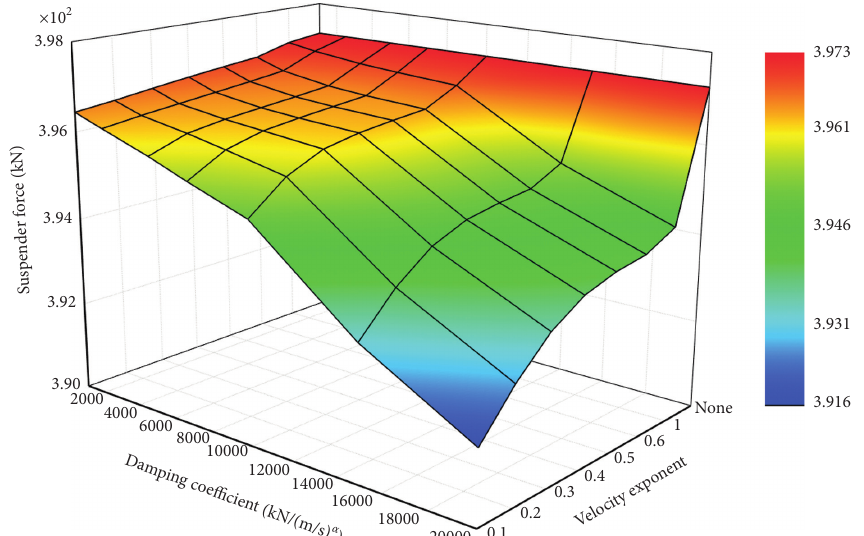
Figure 22: Maximum suspender force F